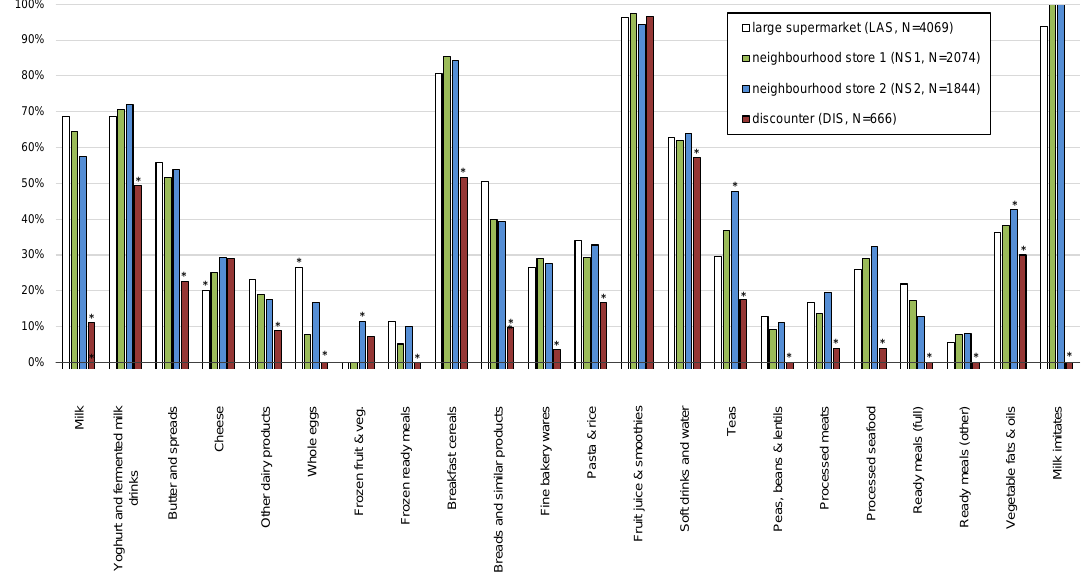
Figure 1. Prevalence of nutrition and/or health claims on pre-packed foods in the large supermarket (LAS), two neighborhood stores (NS) and the discounter (DIS) (Notes: statistically significant difference in the prevalence in comparison to other stores (dual-mode criteria). See Supplementary Table S2).2.2. Consumers’ Exposure to Nutrition/Health Claims and Health Symbols on Pre-Packed